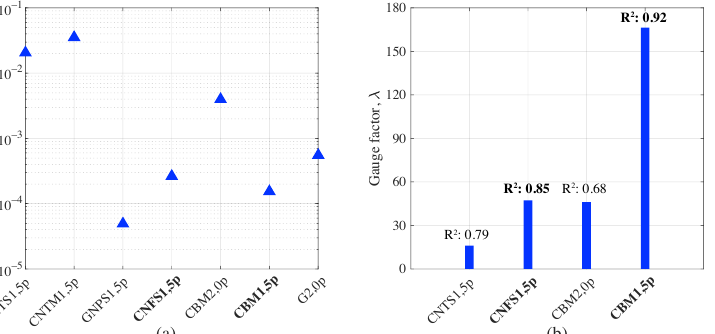
Figure 10. Results from the electromechanical tests: ( a ) conductivities of the doped materials, and ( b ) gauge factor and linearity reliability (R 2 ) of the samples.